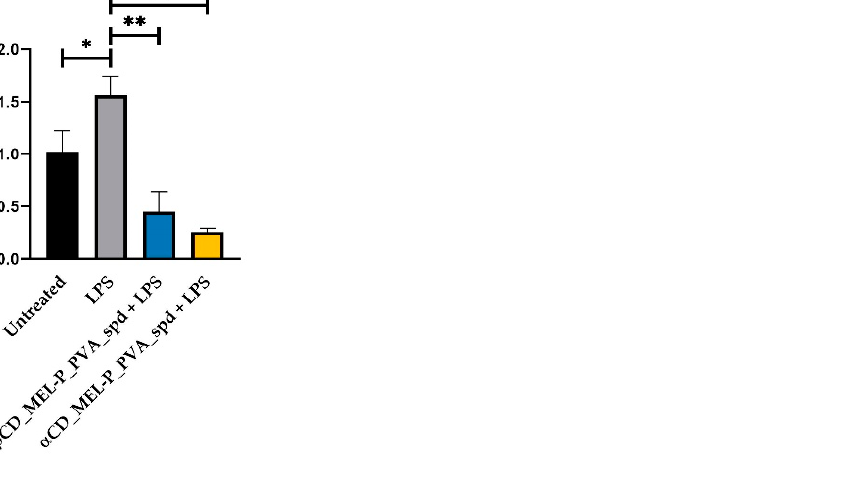
Figure 11. Relative expression of COX-2. (level of significance: * p < 0.05, ** p < 0.01)